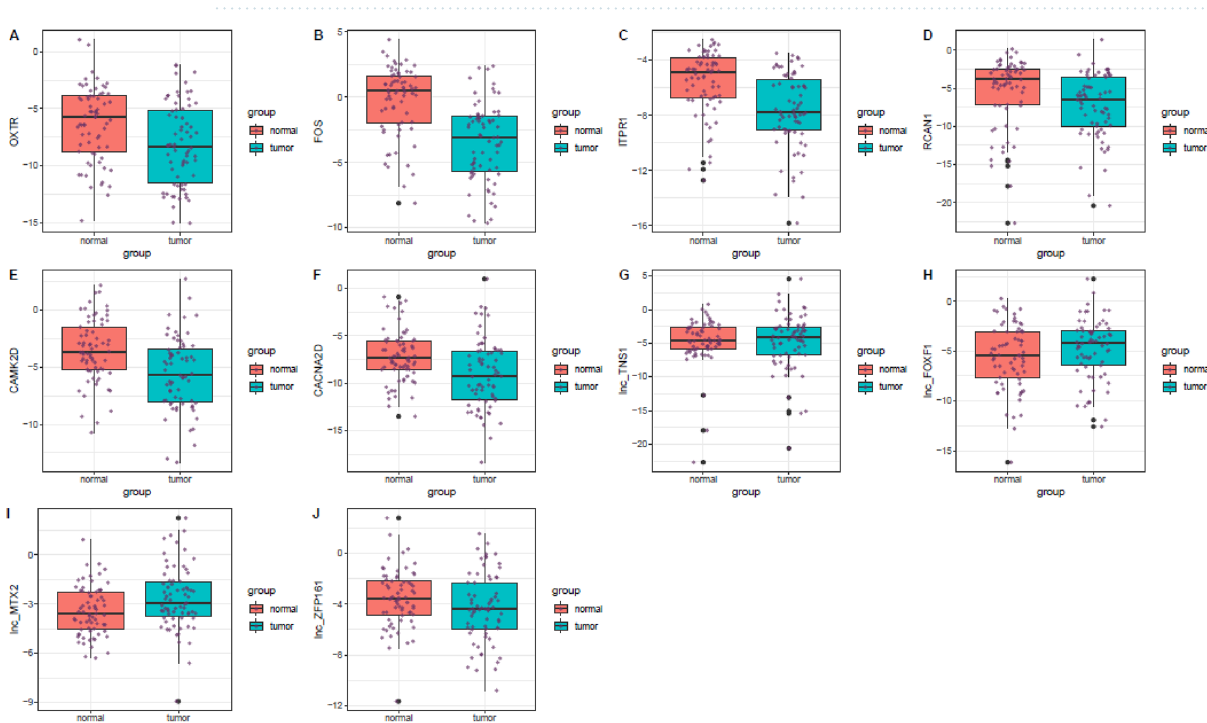
Figure 3. Relative expression levels of oxytocin related genes in breast cancer samples and nearby non- cancerous tissues. Minimum, maximum and interquartile range are shown. Purple dots represent expression of each gene in each sample. Outliers are shown as black